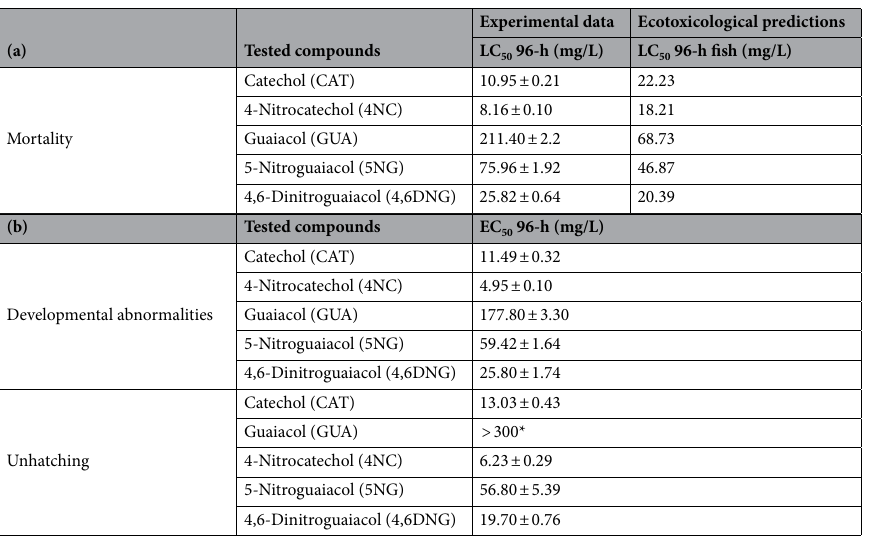
Table 2. Acute toxicity of guaiacol, catechol, and its nitrated products (mg/L): tabular view of toxicological predictions obtained from ECOSAR software for 96-h exposed fish and obtained experimental values for 96-h exposed zebrafish D. rerio embryos. Predicted values were obtained from ECOSAR v2.0 software (https ://www. epa.gov/tsca-scree ning-tools /ecolo gical -struc ture-activ ity-relat ionsh ips-ecosa r-predi ctive -model ). *Maximal effect not reached.